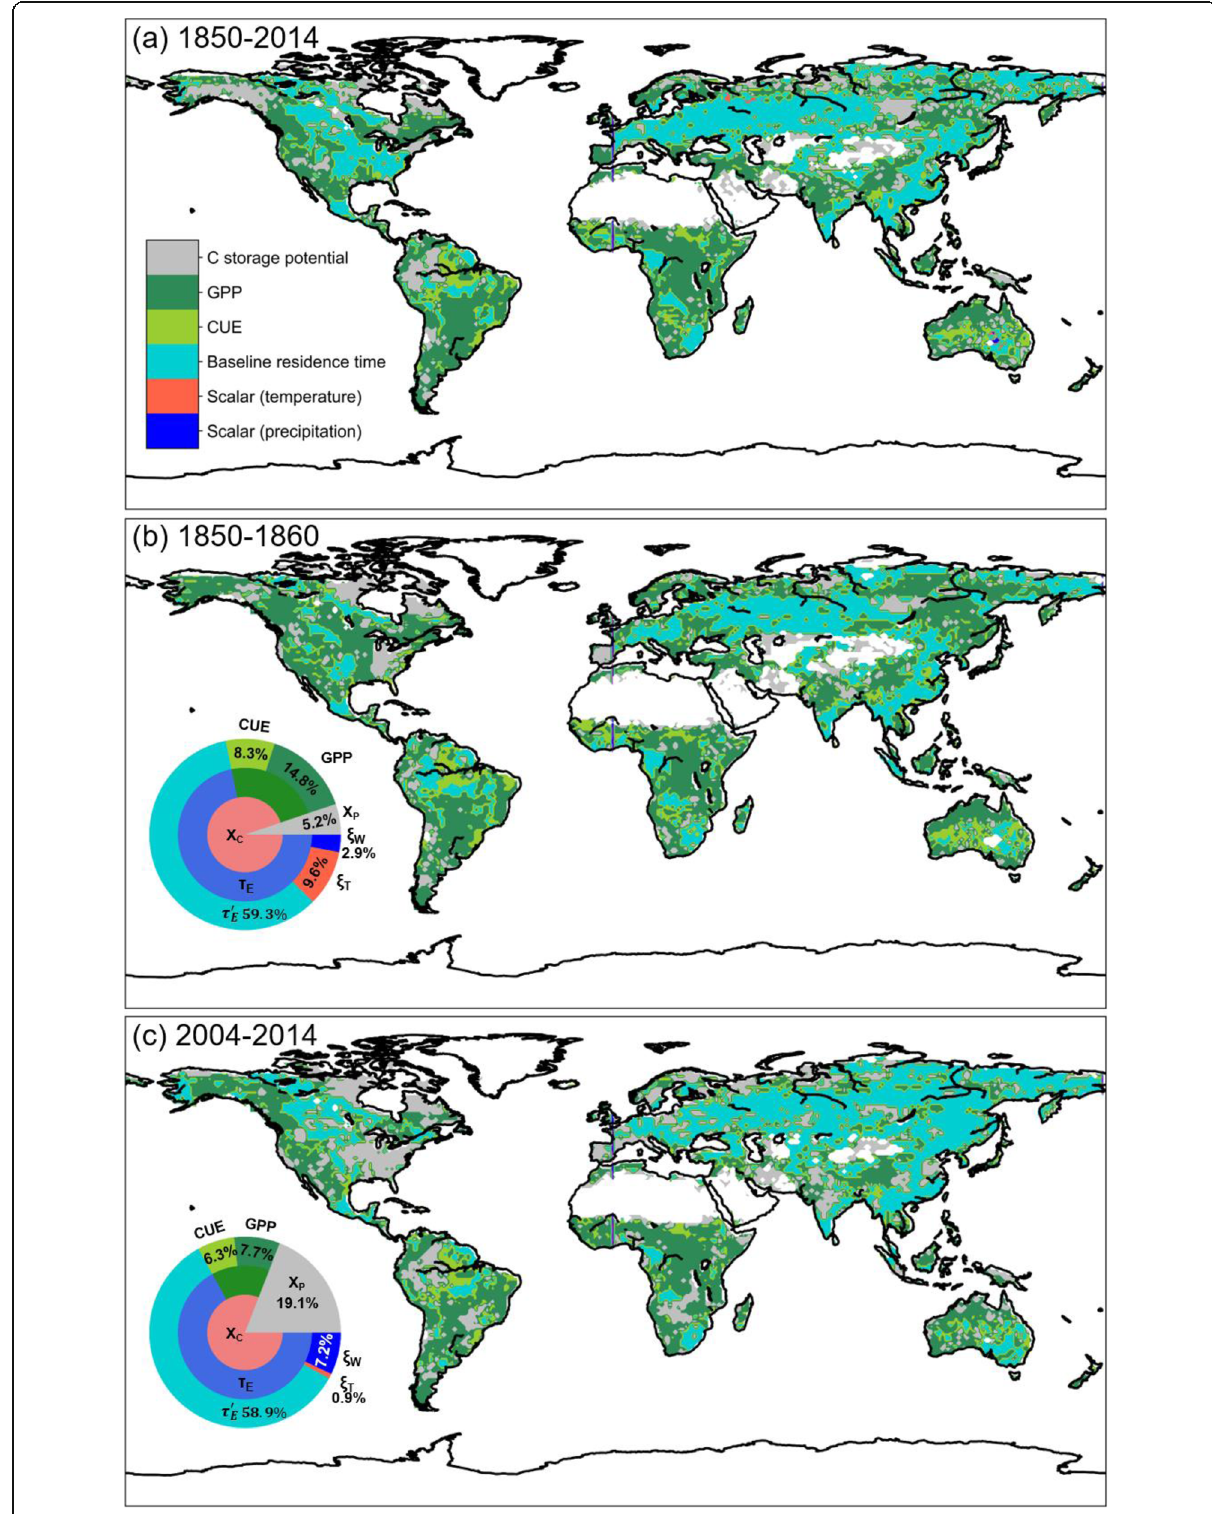
Fig. 9 The global distribution of the dominant variable for the variation in simulated land carbon storage by the models from CMIP6 at different periods: a 1850 – 2014, b 1850 – 1860, and c 2004 – 2014. The subplot of each panel is the variation decomposition of the carbon storage based on annual